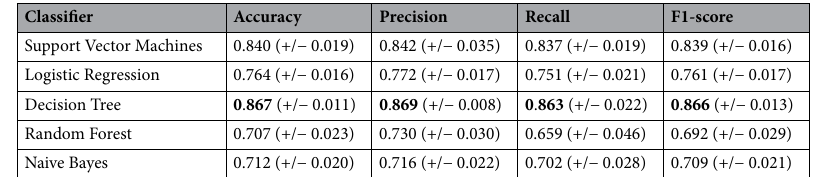
Table 2. Evaluation of tool with simulated data (number of synthetic data points n = 10,000 ) obtained after generative sampling using two different GMM models: one for positive samples, and one for negative samples. We used cross-validation for classification over 10 folds, meaning that for each fold 18,000 samples are used for training and the remaining 2000 are used for testing. Reported error is standard deviation. Bold values indicates the best perfoming